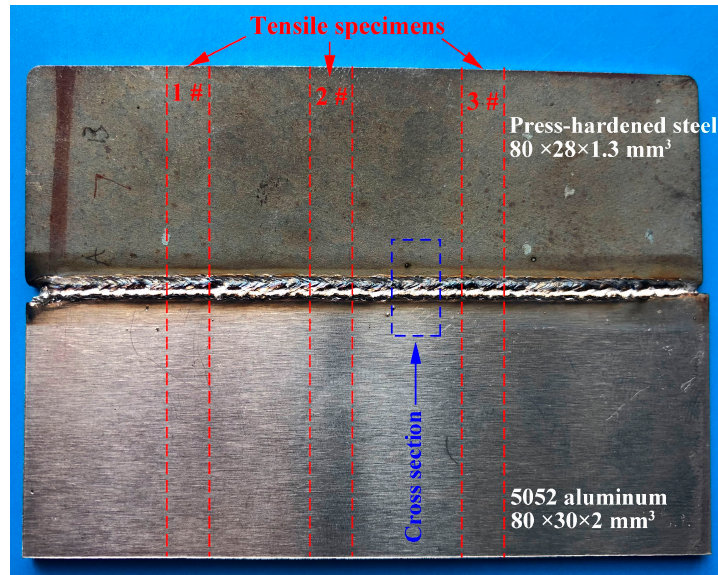
Figure 3. Specific position of tensile specimens and cross-section.